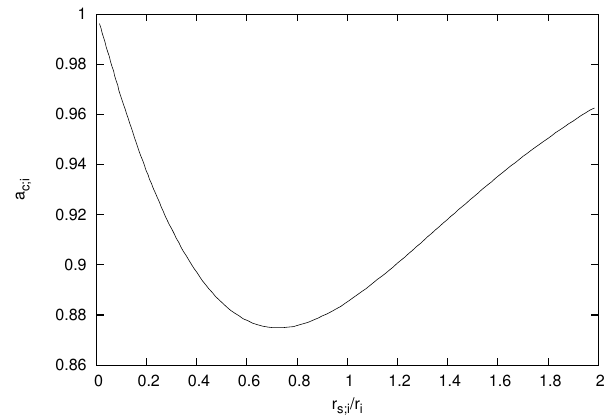
Figure 2. Behavior of the parameters a c ; i ≡ r c / r i as the function of the ratio r s ; i / r i , where r i is given by Equation (5) and r s ; i is the ion Wigner–Seitz radius for the considered electron-ion plasma (5). The presented curve is obtained on the basis of data presented in